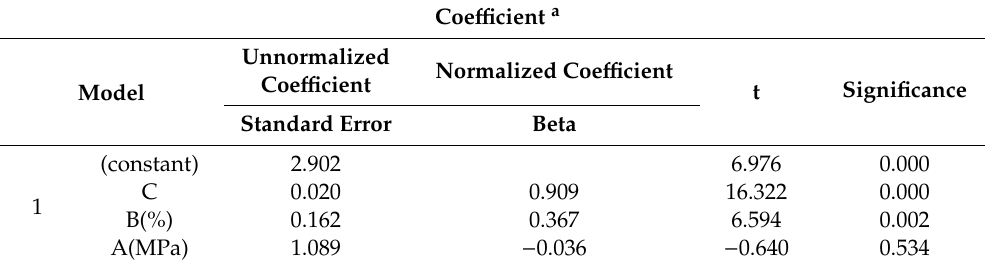
Table 8. Regression coe ffi cient